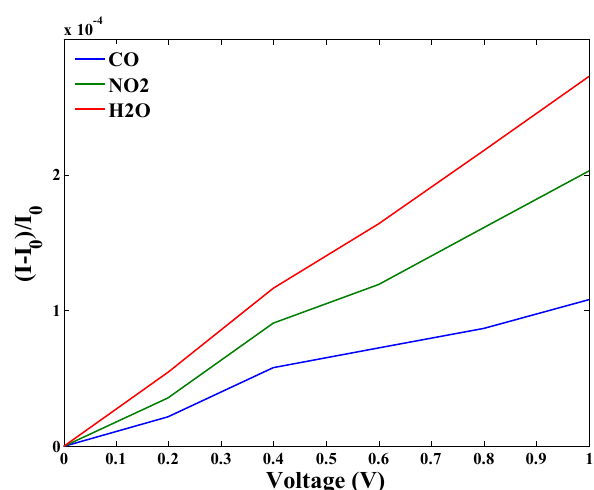
Figure 9. The response of the GFET based sensor toward CO, NO 2 , and H 2 O.